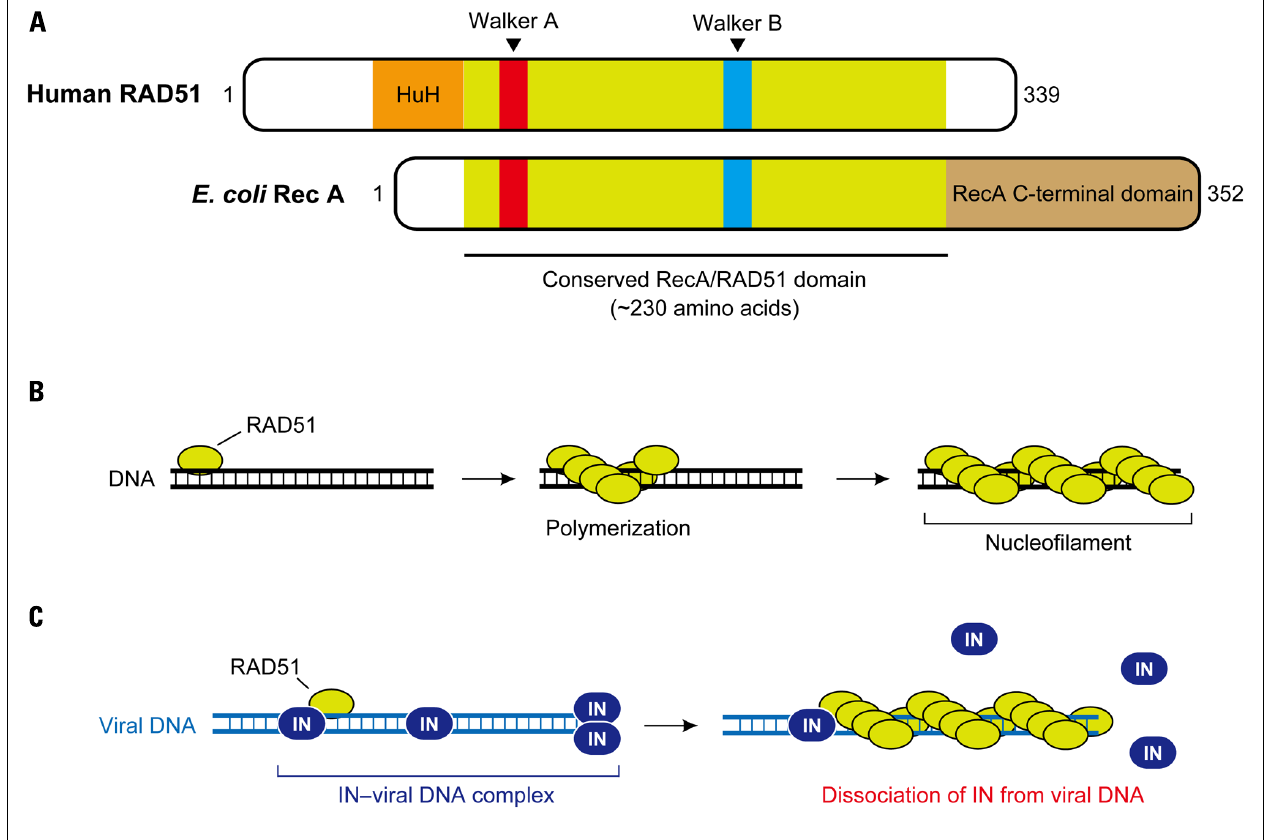
of ATP, and the RAD51-DNA nucleoprotein filament expands to thousands of bases. (C) Disruption of HIV-1 integration complex by the hRAD51 nucleofilament. It is suggested that formation of an active nuclear filament following polymerization of hRAD51 on viral DNA eventually displaces IN, thereby inducing dysfunction of the HIV-1 integration complex prior to the integration reaction. Recruitment of hRAD51 onto viral DNA may be facilitated by its interaction with